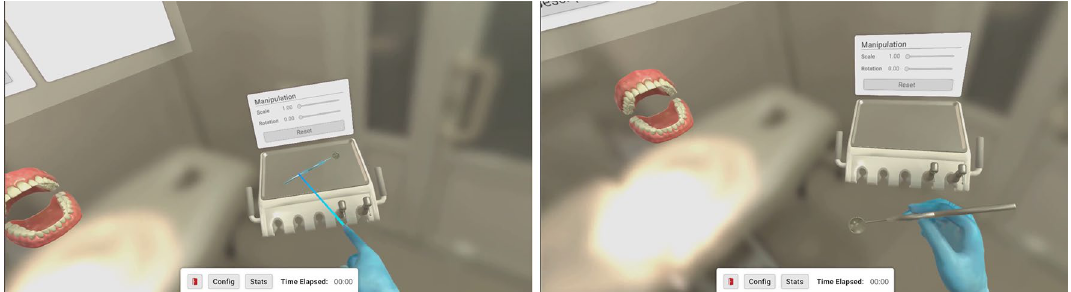
Figure 1. Tool selection process: using the controller, the user points their hand towards the instrument tray and at their desired tool. The selected tool is highlighted in blue and upon pressing the trigger is equiped in the user’s hand. The user may press the cancel button to release the